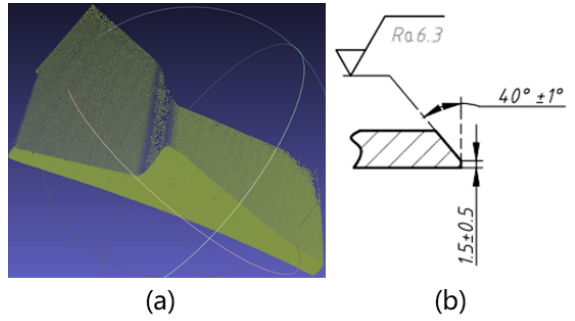
Figure 19. The evaluation of the processing result. ( a ) Point cloud data of the milling result; ( b ) the processing requirements.